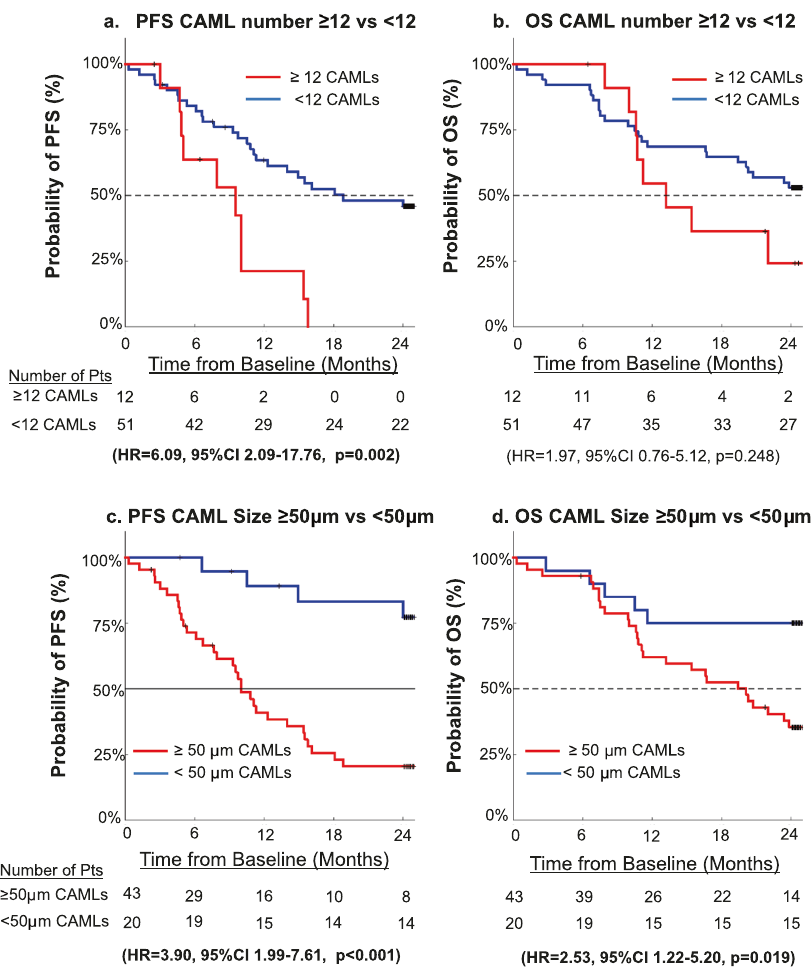
Fig. 4 Kaplan – Meier graphs of PFS and OS for CAML number or size. Using ≥ 12 CAMLs as a threshold, Kaplan Meier graphs for a PFS and b OS. Using ≥ 50 μ m as a threshold for largest CAML size, Kaplan – Meier graphs for c PFS and d